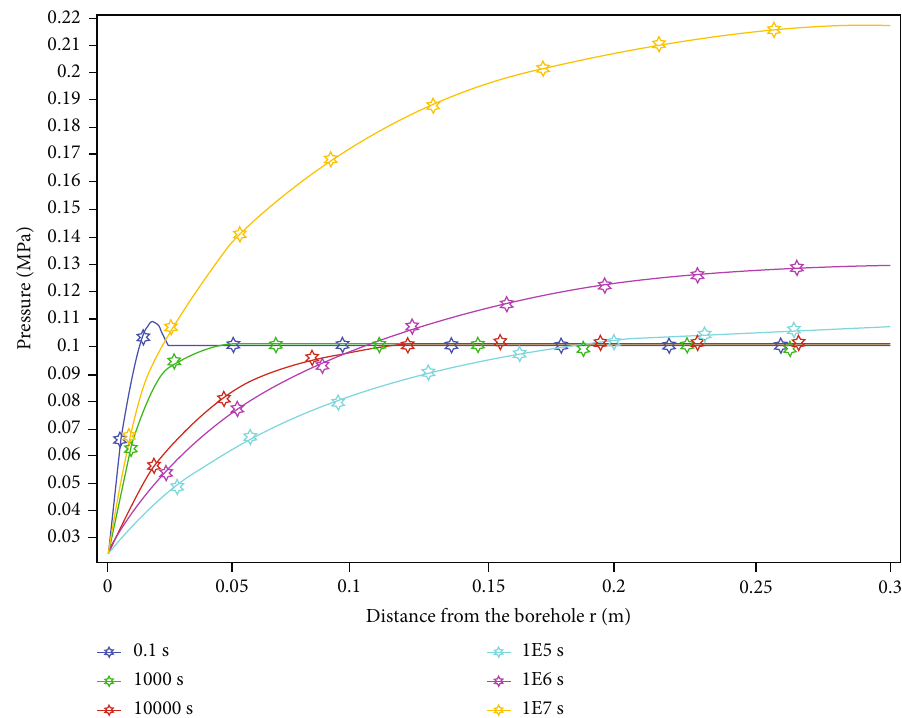
Figure 16: Pore pressure in the m = 7 coal rock during CBM